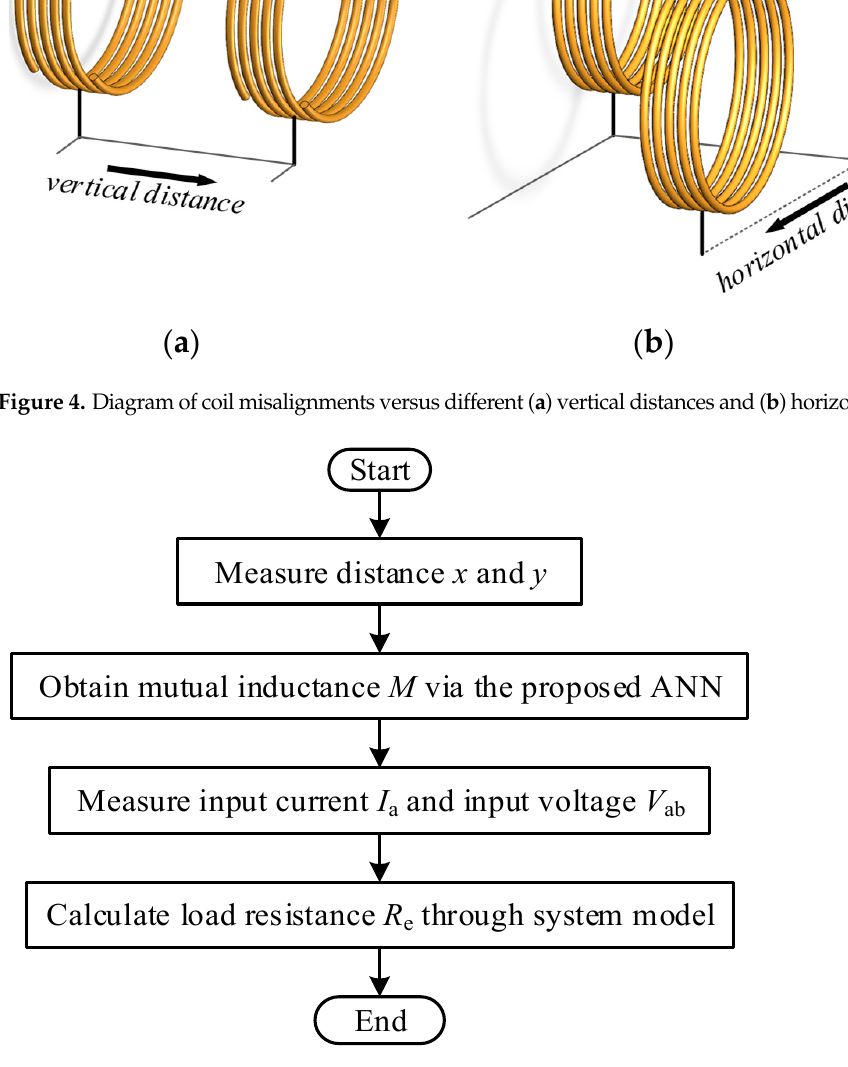
Figure 5. Flow chart of the identification process.